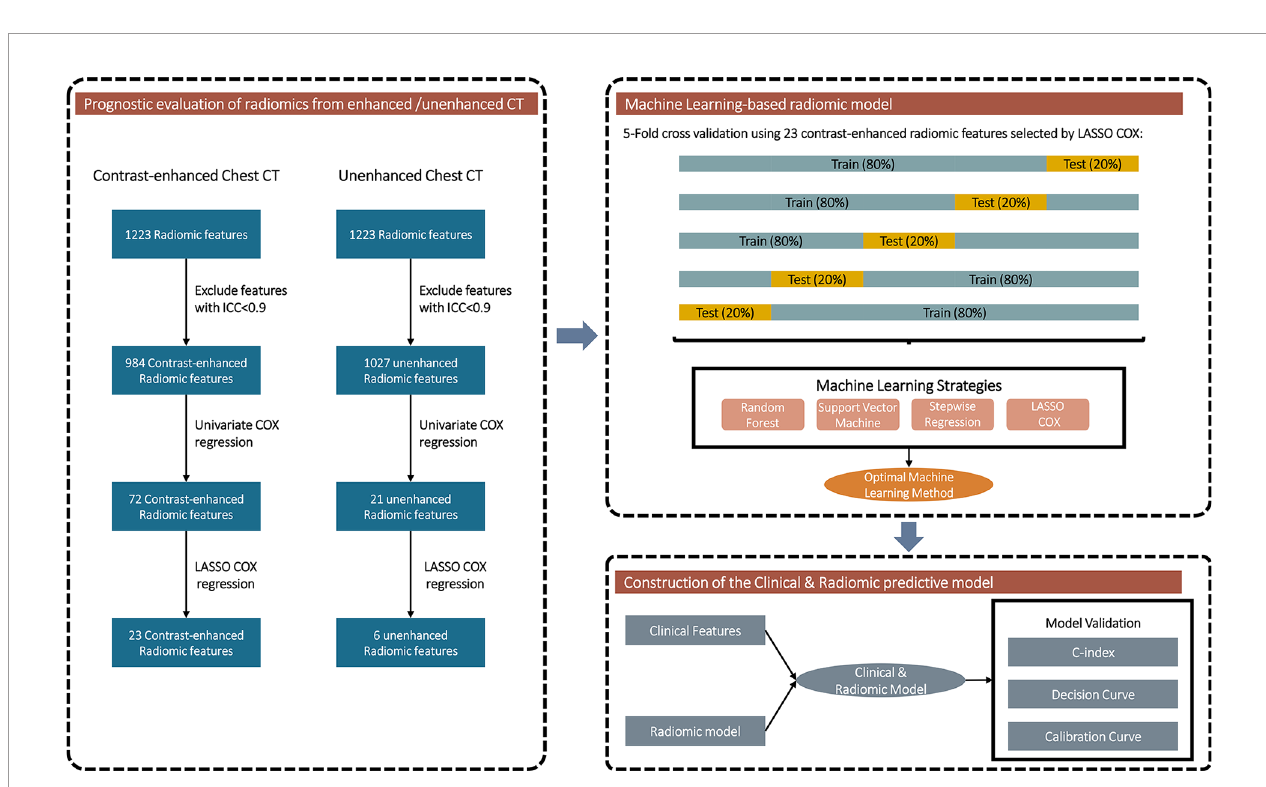
FIGURE 1 | Forest plots depicting the prognostic value of various clinical factors (A) and morphological CT features (B) in predicting the PFS of patients with EGFR - T790M mutation after second-line osimertinib therapy. PFS, Progression-free survival.